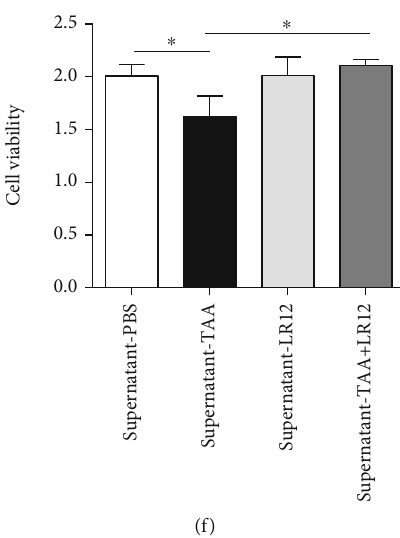
Figure 3: LR12 promoted hepatocyte proliferation via macrophages in LO2 cells. (a) THP-1 cells were successfully di ff erentiated into macrophages by PMA (100ng/mL). (b) Immuno fl uorescence images of F4/80 staining and DAPI in macrophages. (c) CLSM showing CK18 and PCNA staining in LO2 cells stimulated with the macrophage supernatant. (d) Western blot analysis of PCNA in LO2 cells stimulated with the macrophage supernatant. (e) The LO2 cell cycle detected by fl ow cytometric analysis. (f) CCK-8 assay analysis of LO2 cell viability. Data were presented as the mean ± standard deviation (SD). ∗ P < 0 : 05 , ∗∗ P < 0 : 01 , and ∗∗∗ P < 0 : 001 versus control analyses. We also attempted to present data in the form of mean ± standard deviation (SD). We utilized one-way analy-